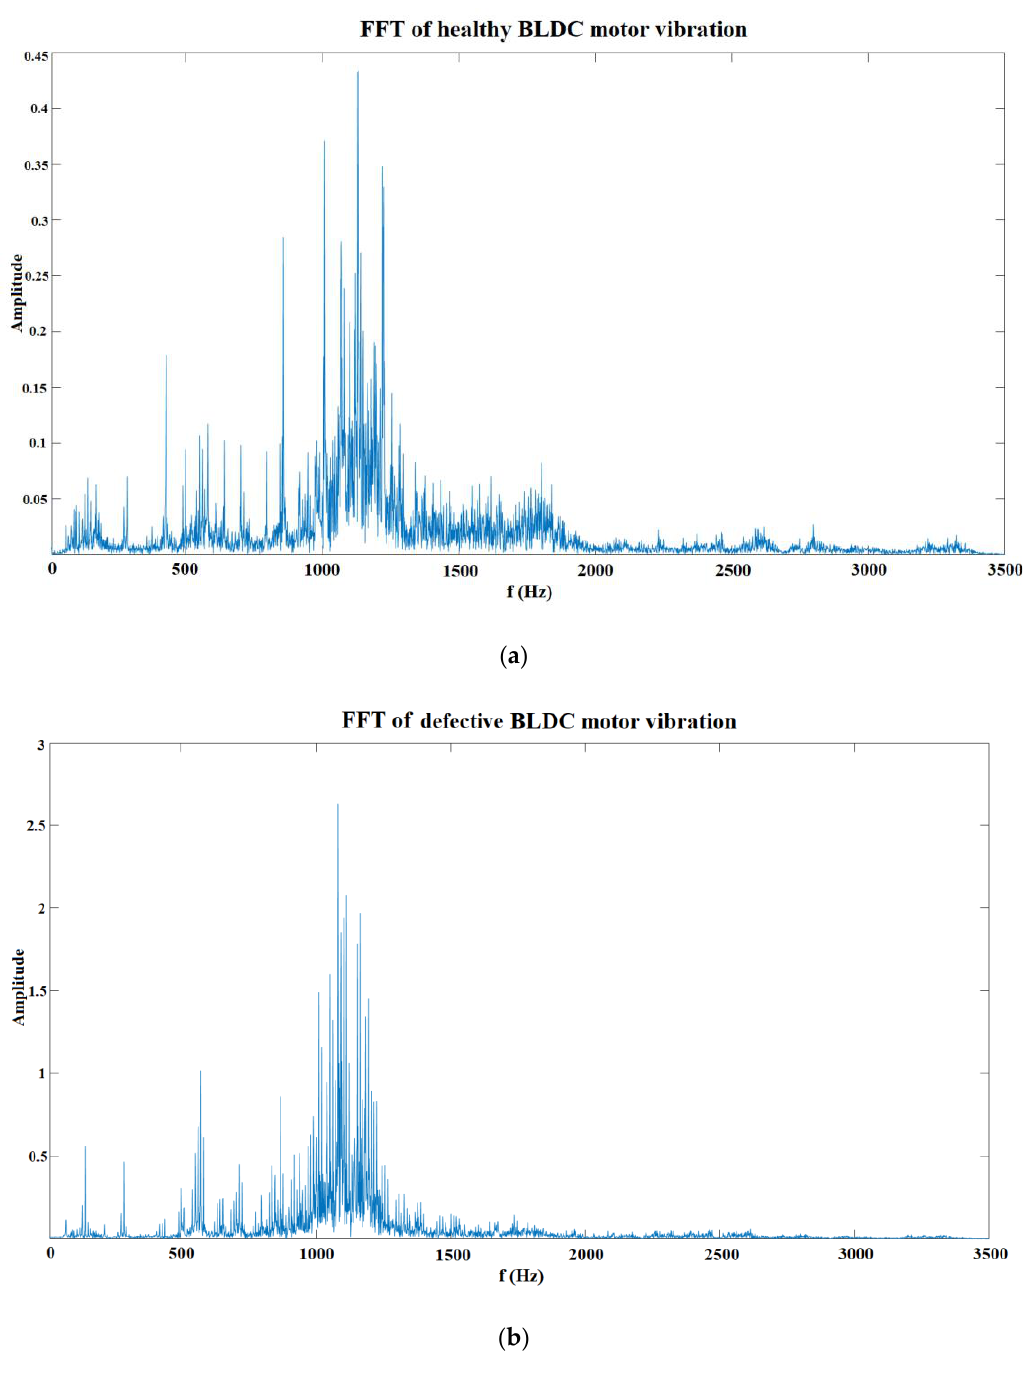
Figure 4. Fast Fourier transform (FFT) of the vibrations of healthy ( a ) and defective ( b ) BLDC